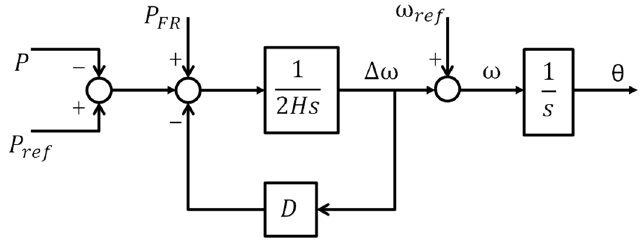
Figure 2. Virtual synchronous machine control loop.